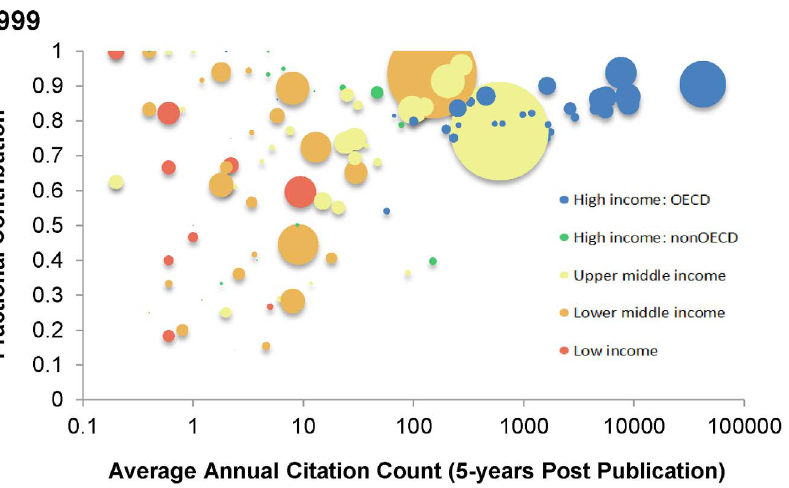
Figure 2. Country-level fractional counts against logarithmic annual citation counts in 1999 (A) and 2008 (B). Country-level fractional counts (scale: 0–1) against logarithmic annual citation counts (country-level cardiovascular research output) with color coding representing World Bank country income status. Fractional counts represent the proportion of each country’s authors against the total number of authors on each publication. The size of each country’s bubble represents the population size of that country. Average citation index (ACI) is calculated by dividing a